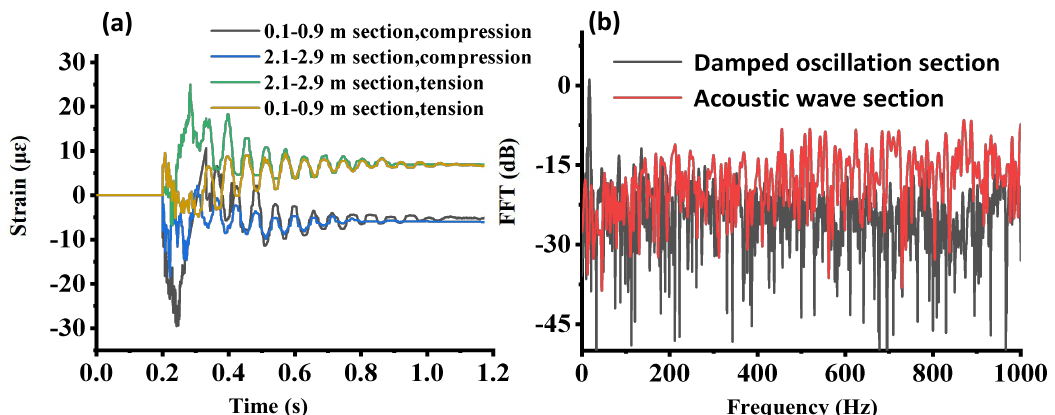
Figure 8. ( a ) Distributed dynamic strain measurement by the CP ϕ − OTDR for the left span and right span, and ( b ) FFT analysis of the damped oscillation section and acoustic wave section with the same drop height of 40 mm at